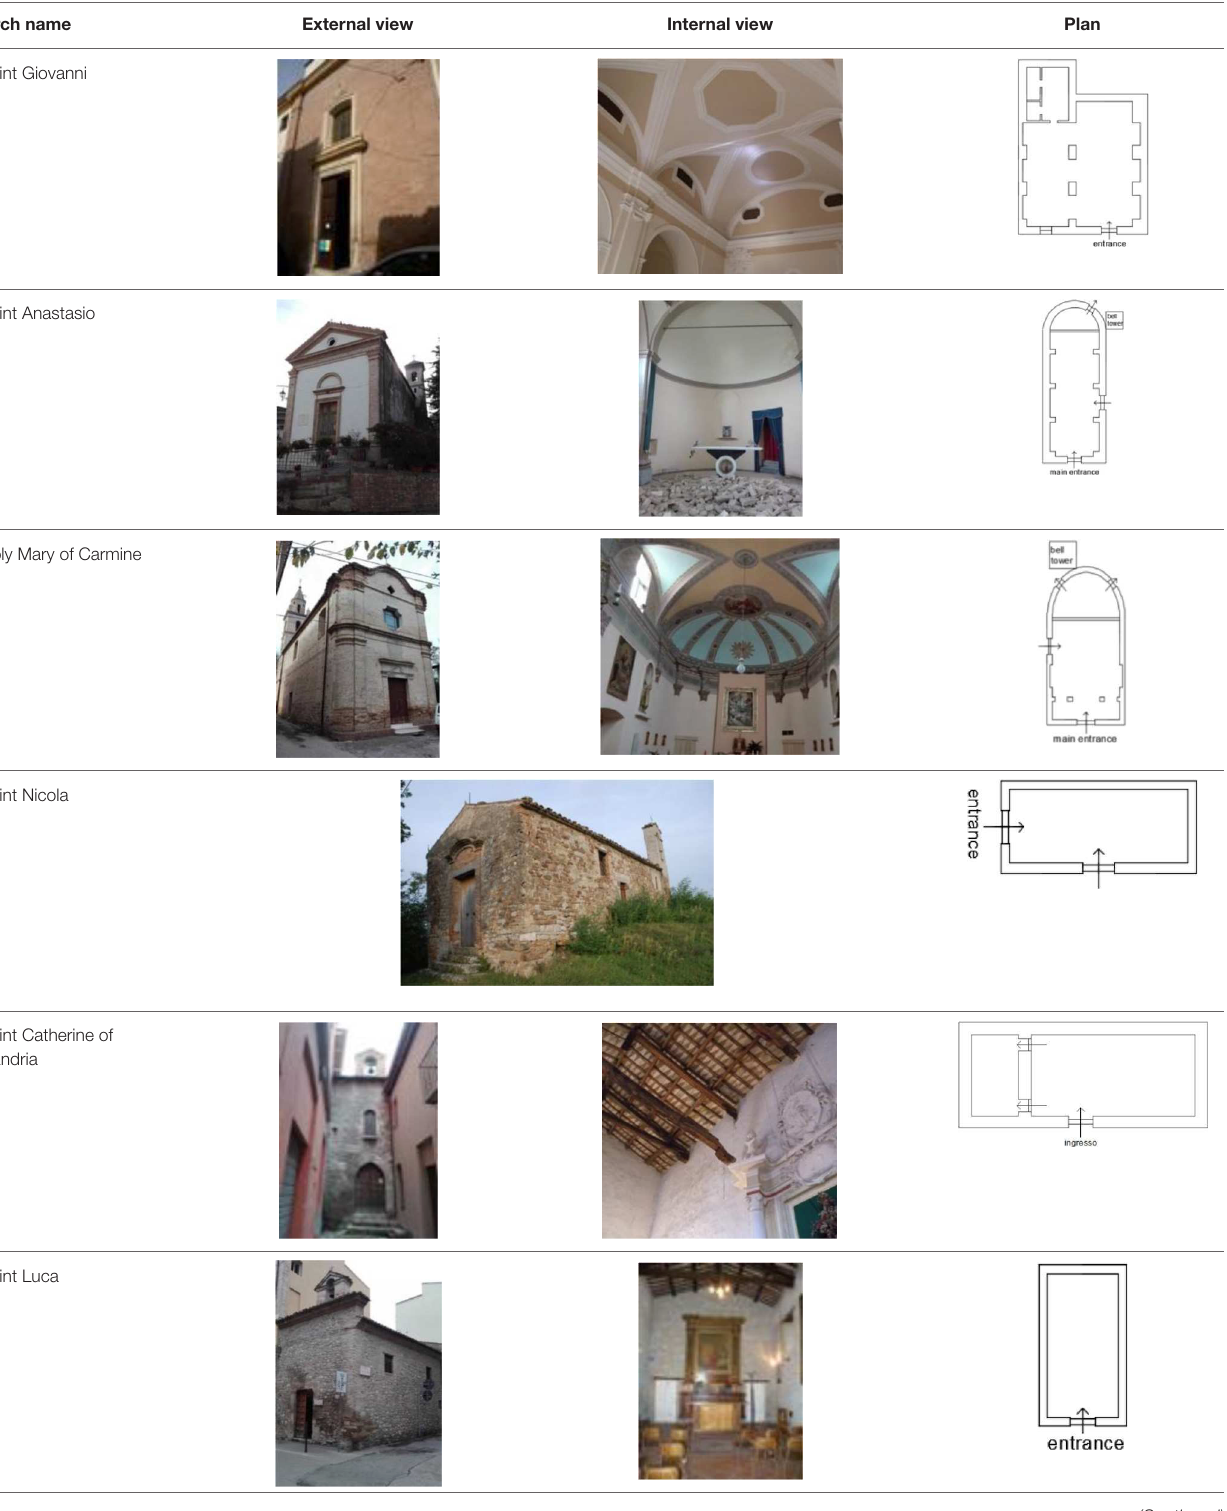
TABLE 3 | Geometrical features of churches investigated in